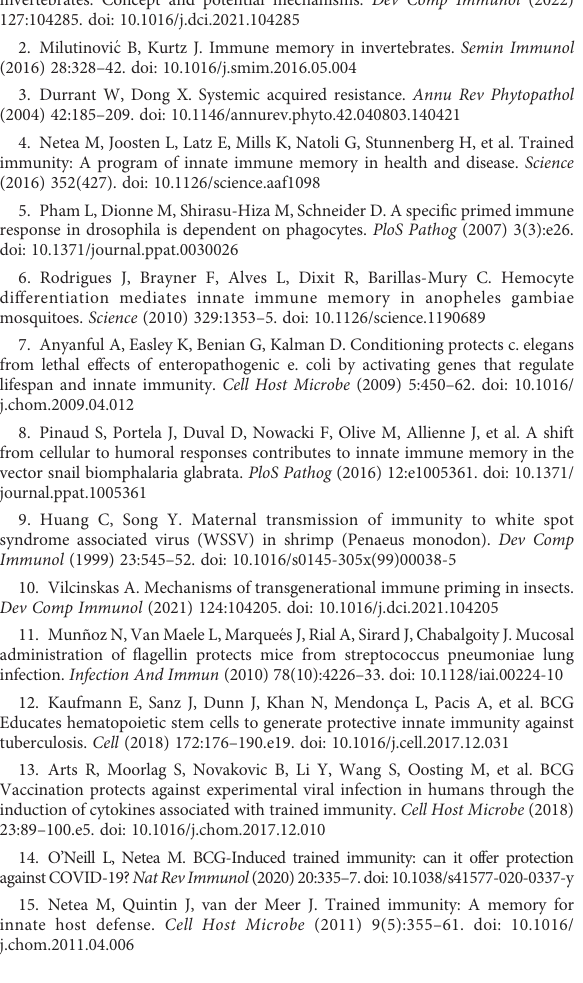
List of candidate genes. A list of 80 candidate genes identi fi ed in QTL analysis. The LOD peak, gene symbol, Flybase ID, GO terms (biological process, cellular component, molecular function), location arm, location max, location min, and gene name are listed.